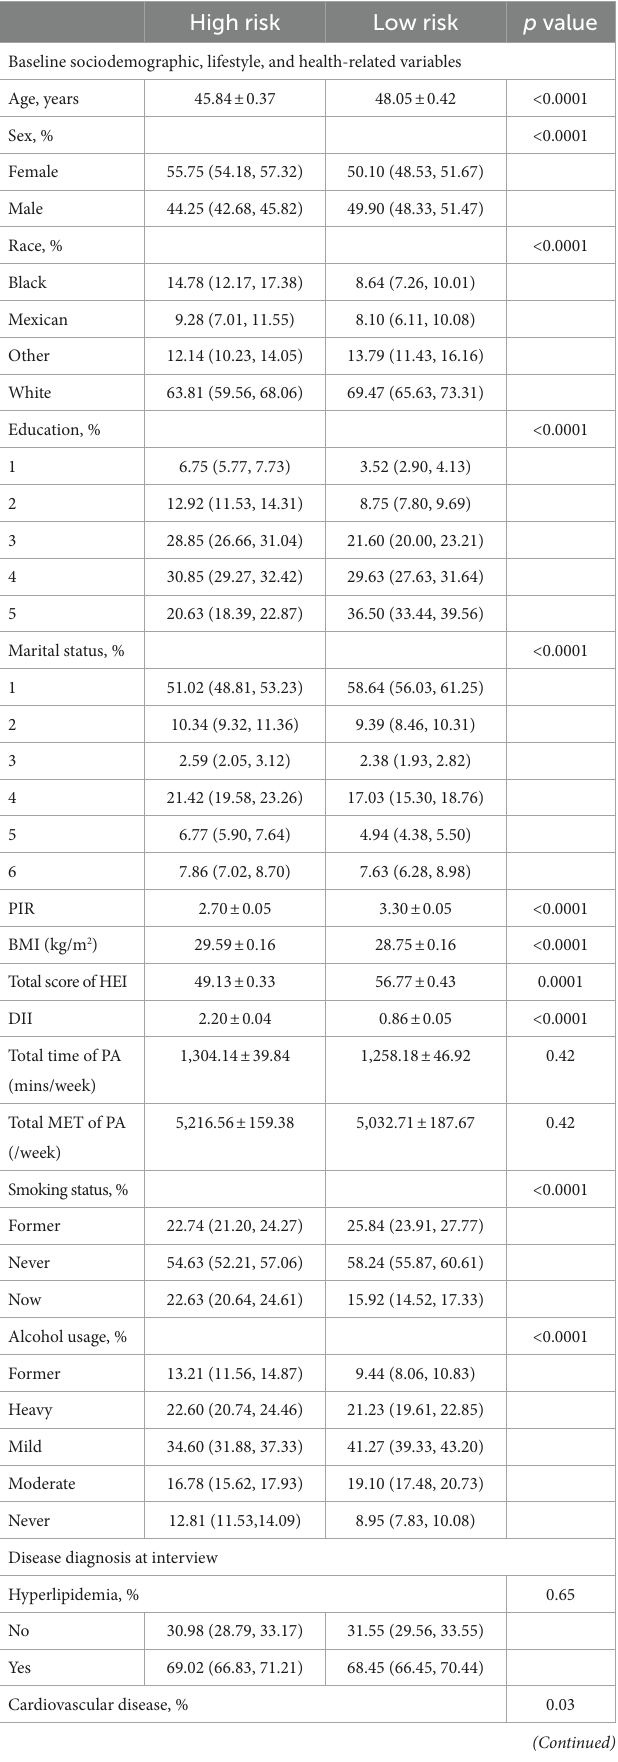
TABLE 5 Relevant baseline variables according to the risk